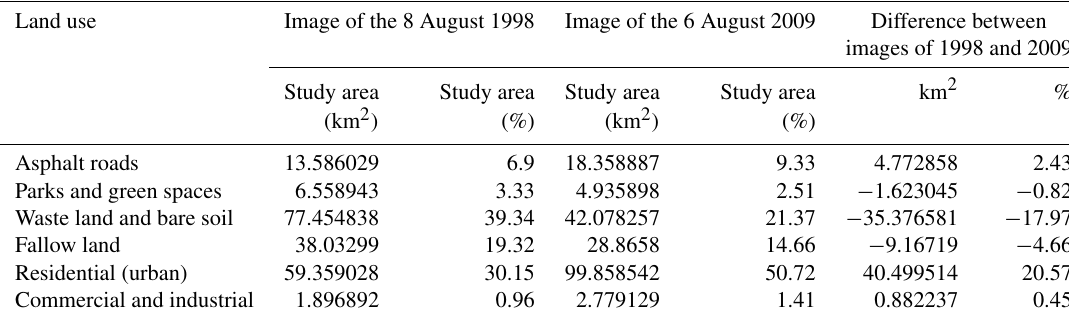
Table 4. Land use distribution of Yazd city using maximum likelihood